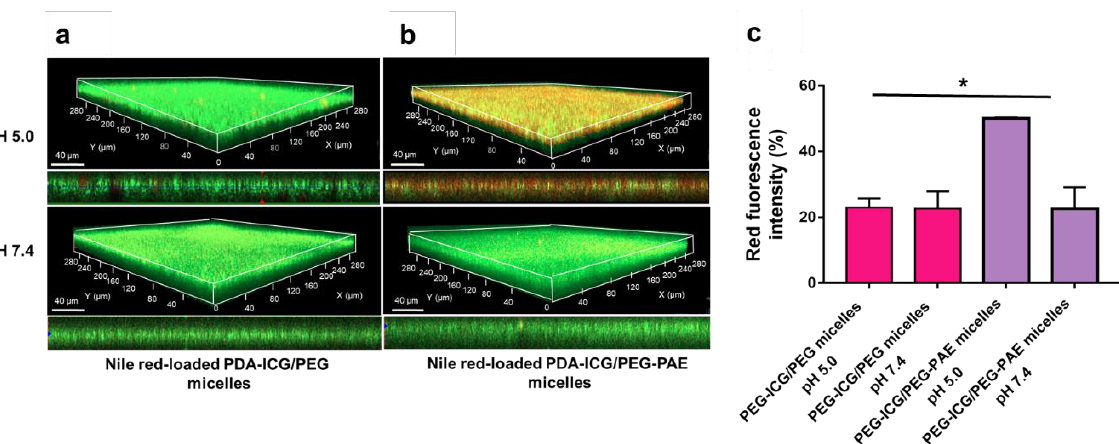
Figure 3. Targeting of S. aureus Xen36 biofilms by photothermal PDA-ICG-NPs after micellar encapsulation at pH 5.0 and 7.4. ( a ) CLSM micrographs of targeting, penetration and accumulation of encapsulated PDA-ICG-NPs into 48 h grown S. aureus biofilms, exposed for 60 min to PDA-ICG-NPs encapsulated in Nile red-loaded PEG micelles in suspension (0.5 mg/mL) for 60 min at different pH. ( b ) Same as panel a, now for encapsulation in PEG-PAE micelles. ( c ) Percentage red-fluorescence intensity upon accumulation of PDA-ICG-NPs encapsulated in Nile red-loaded micelles in S. aureus at pH 5.0 and pH 7.4. The percentage red-fluorescence intensity was expressed relative to the total (red and green) fluorescence intensity. Data represent means with standard deviations over 3 experiments with separately prepared batches of nanoparticles and bacterial cultures. * indicate statistically significant differences between the data indicated by the spanning bars (one-way ANOVA; * p <